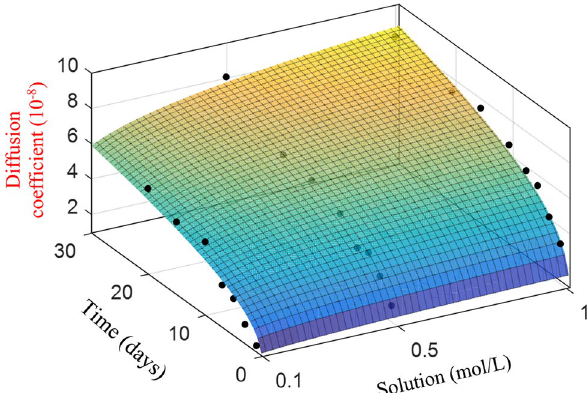
Fig. 7 Time-dependent diffusion coefficient and fitting